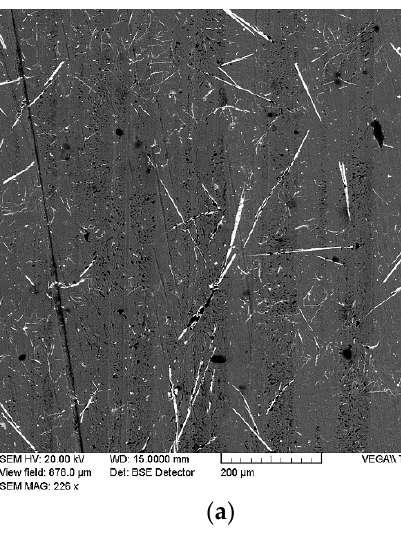
Figure 11. The structure of friction surfaces after tests performed under a load of 120 N on the samples of the combined coating made from the AlSi12 alloy with the lead sublayer ( a ) and with the addition of tin ( b ).